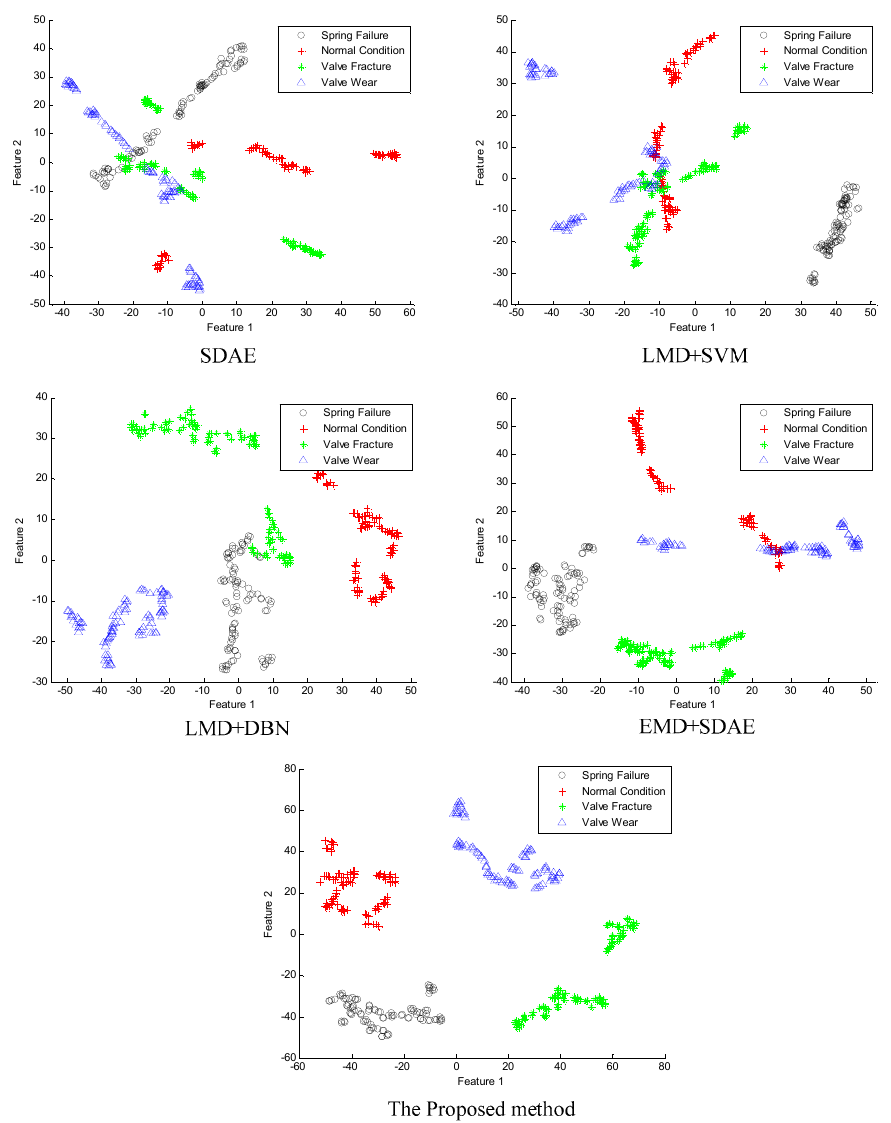
Figure 11. Fault feature extraction chart of the valves in different methods.